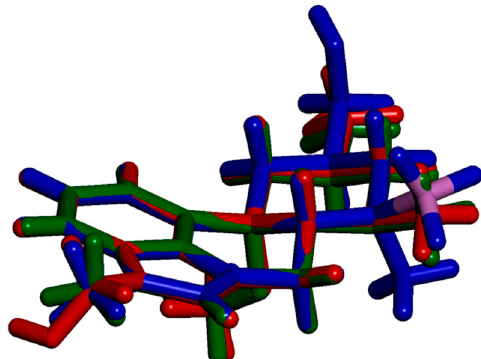
Figure 5. Side-oriented fitted molecules of Luol derivatives. BH 3 -MeLuol ( 4) —blue, Luol ( 5 )—red, MeLuol ( 3 )—green, boron—pink.